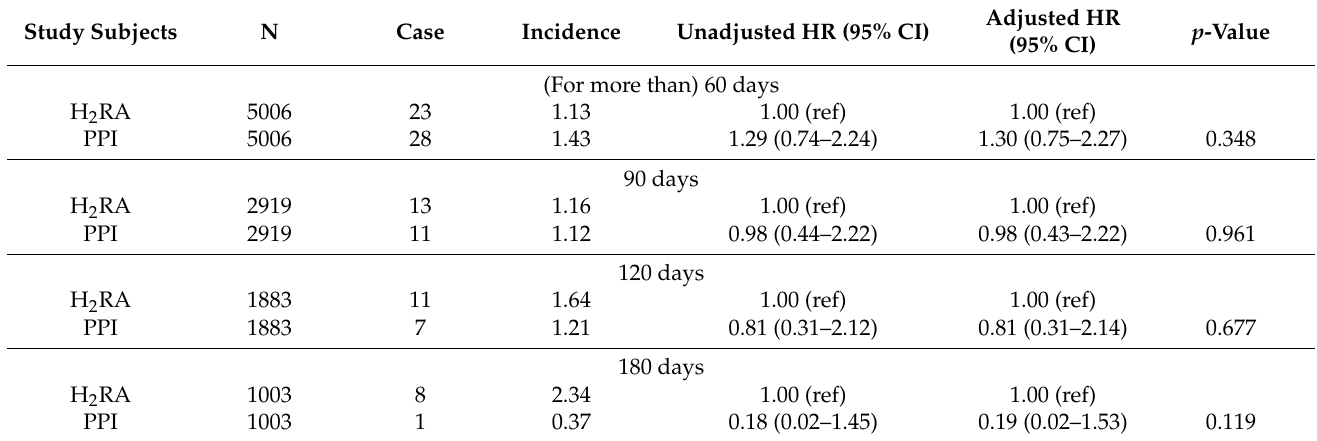
Table 2. Incidence per 1000 person-years and hazard ratios of gastric cancer development between histamine-2 receptor antagonist and proton pump inhibitor user group according to the duration of